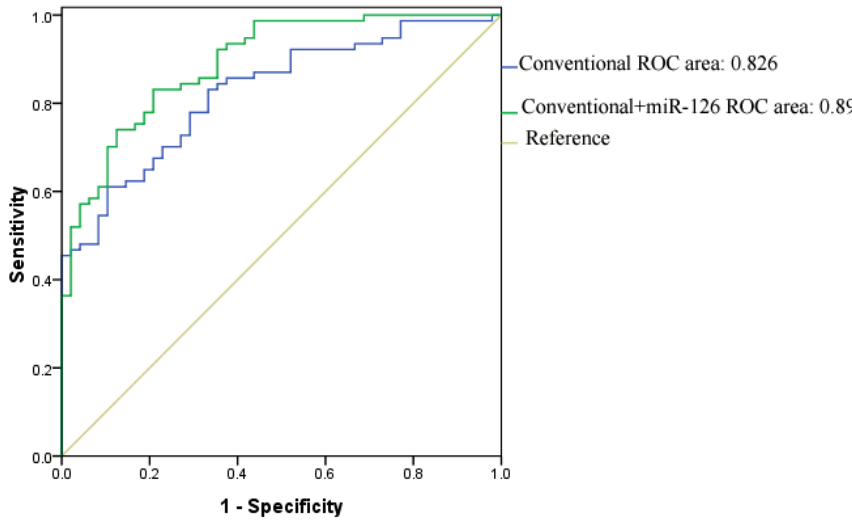
Figure 3. ROC curves and corresponding AUCs for new-T2DM. The AUC in an established conventional model was 0.826 (95% CI, 0.756–0.897). After circulating miR-126 levels were introduced, the AUC was 0.893 (95% CI, 0.838–0.947). Abbreviations: AUC, area under the curve; CI, confidence interval; ROC, receiver operating